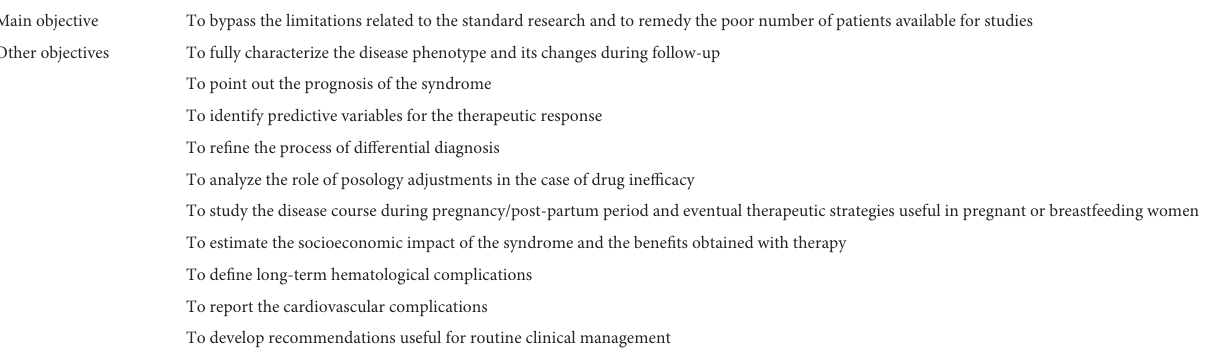
TABLE 2 Objectives of the registry dedicated to Schnitzler’s syndrome in the platform of AIDA